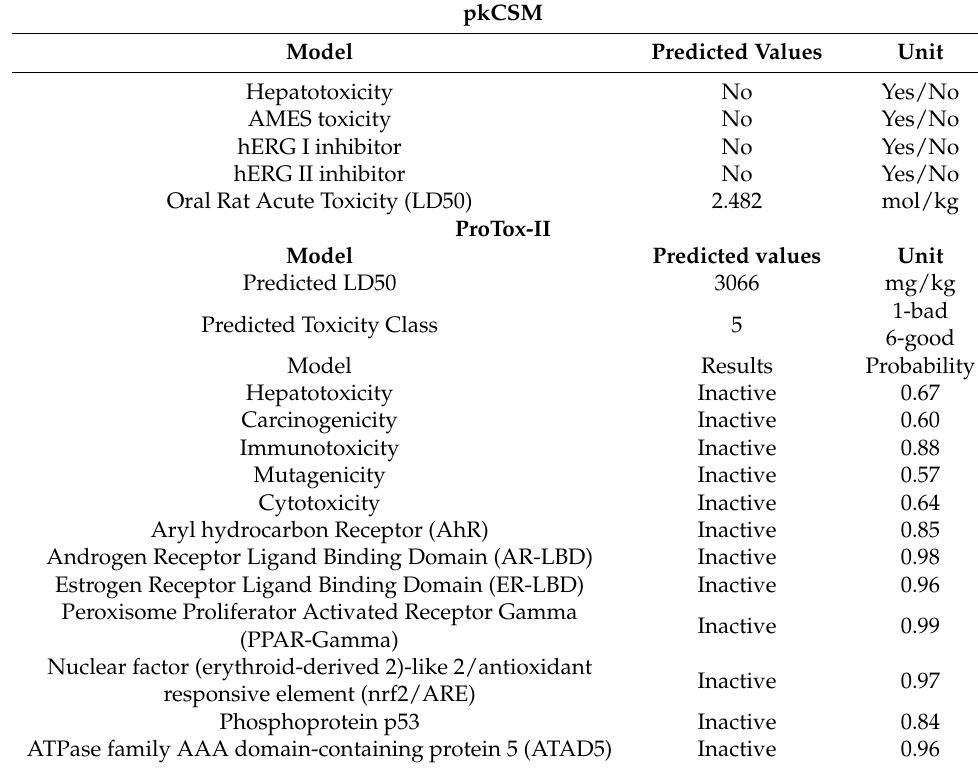
Table 3. Toxicity predictions for TMPyP4, using pkCSM and ProTox-II web services. pkCSM